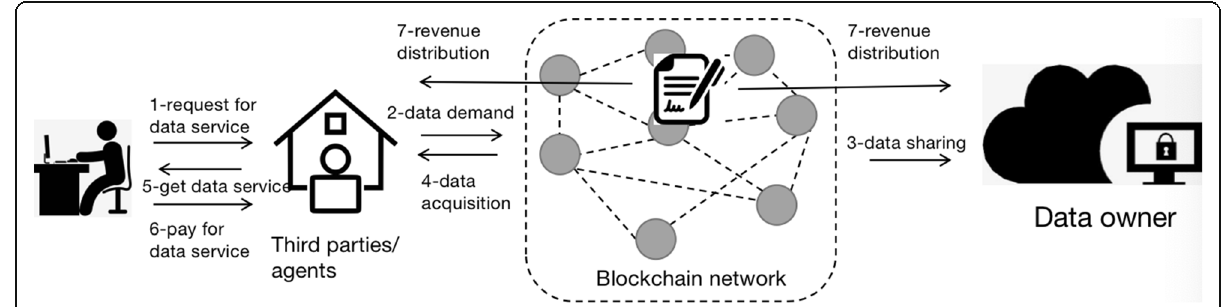
Fig. 19 Data sharing architecture for cloud data sharing